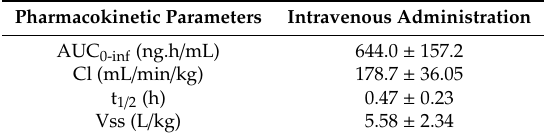
Table 2. Pharmacokinetic parameters of TMP (mean ± SD) after a single administration of a